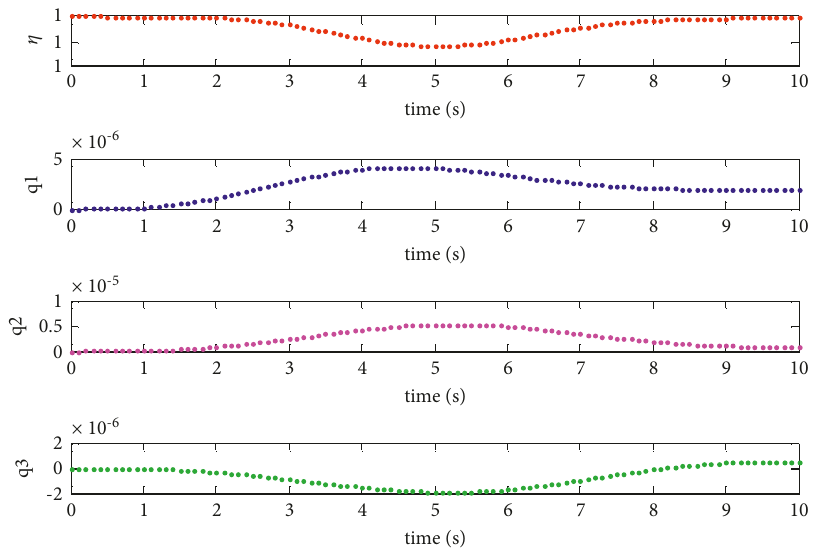
Figure 8: The attitude of the base obtained by the QPSO algorithm.